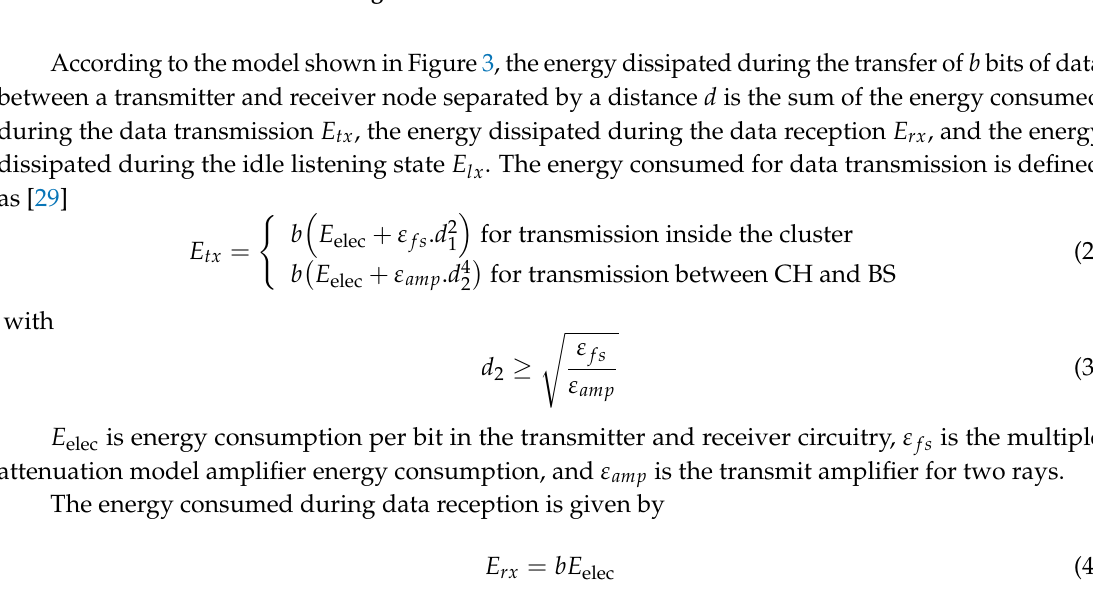
Figure 3. Classical radio channel model.